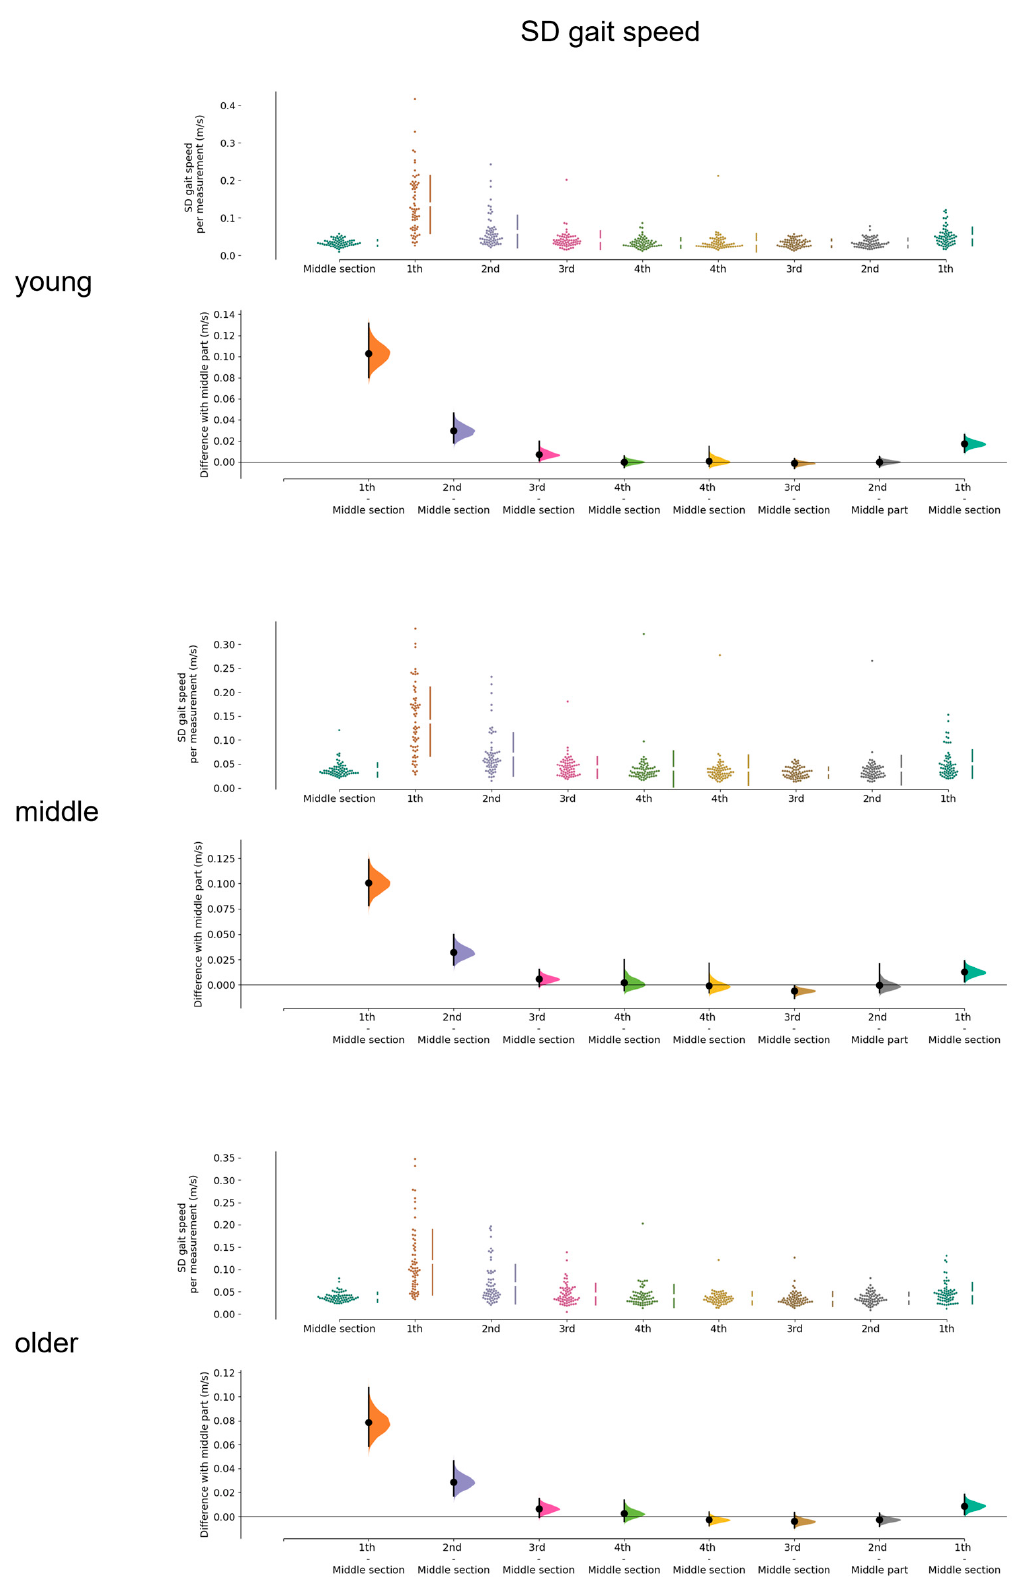
Figure A2. SD of the different participants during the walking trajectory, and the mean differences and associated 99% CI of the first and last 4 strides around a turn. The top subplot includes data of the young age group, the middle subplot, the middle age group, and the bottom subplot, the older age group.